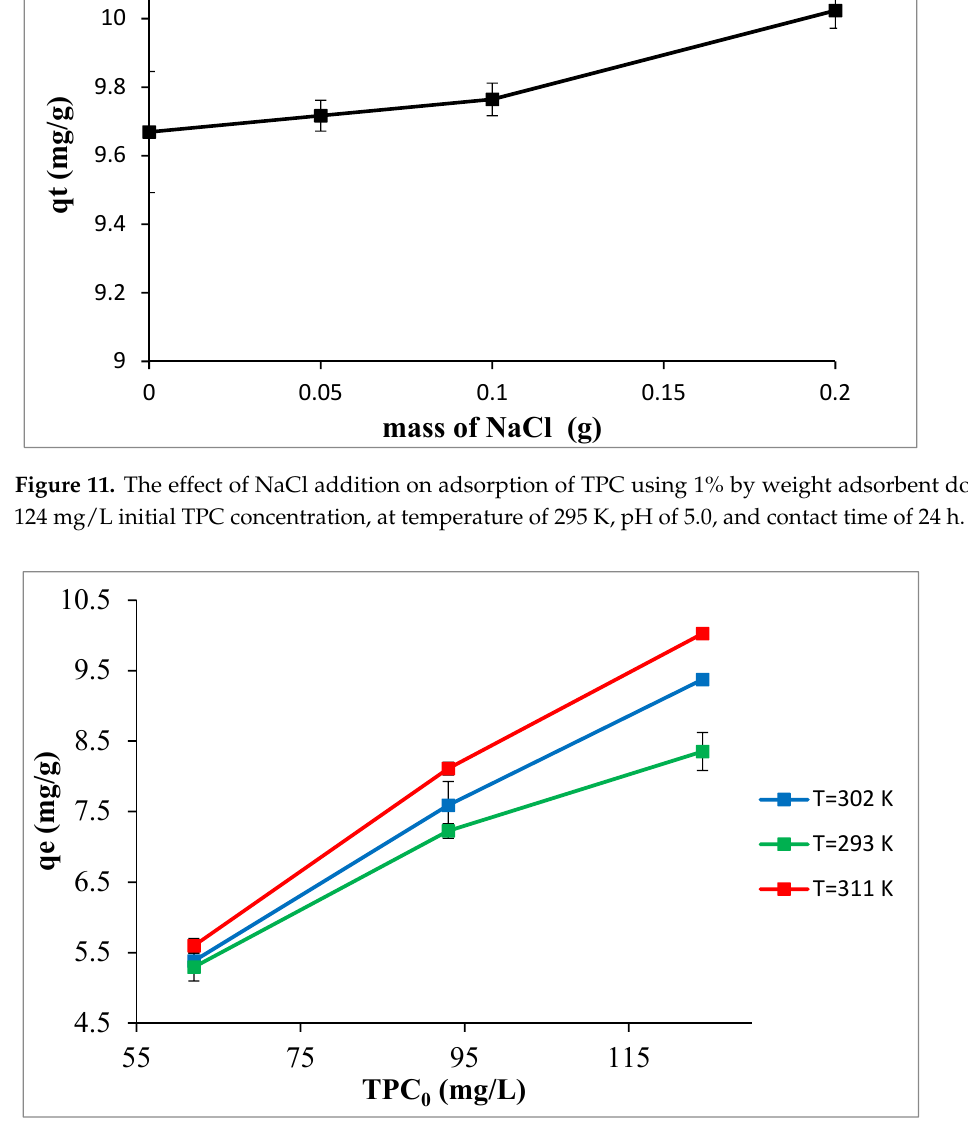
Figure 12. The temperature effect on the TPC uptake using 1% adsorbent dose, pH 5.0, and initial TPC 124 mg/L. Table 3. Thermodynamic parameters evaluated at different temperatures.